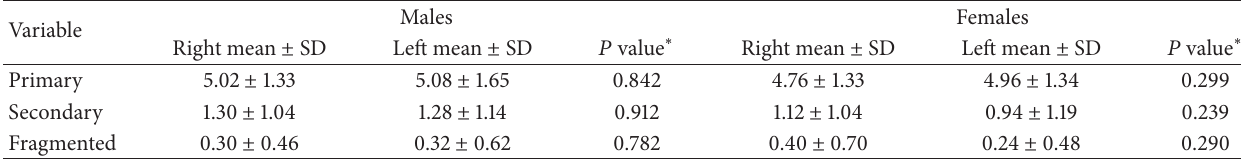
Table 4: Bilateral differences (left-right) in rugae lengths in both sexes.